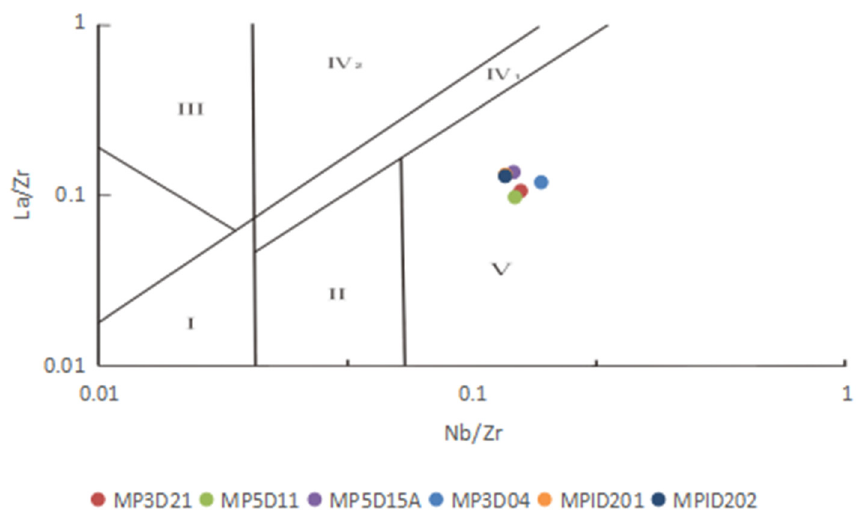
Figure 9. La/Zr–Nb/Zr structural discrimination diagram of seamount basalts from the Western Pacific (after Wu, L.N. et al., 2003 [46]) I: N-morb region of divergent plate boundaries; II: convergence plate boundaries; III: ocean island and seamount basalt region, including T-morb and E-morb oceanic plate regions; IV: continental plate interiors, of which IV 1 is the intracontinental rift and marginal rift tholeiitic basalt area, IV 2 is the intracontinental rift alkaline basalt area, and IV 3 is the continental tension zone (or initial rift) basalt region; V: mantle plume basalt region.